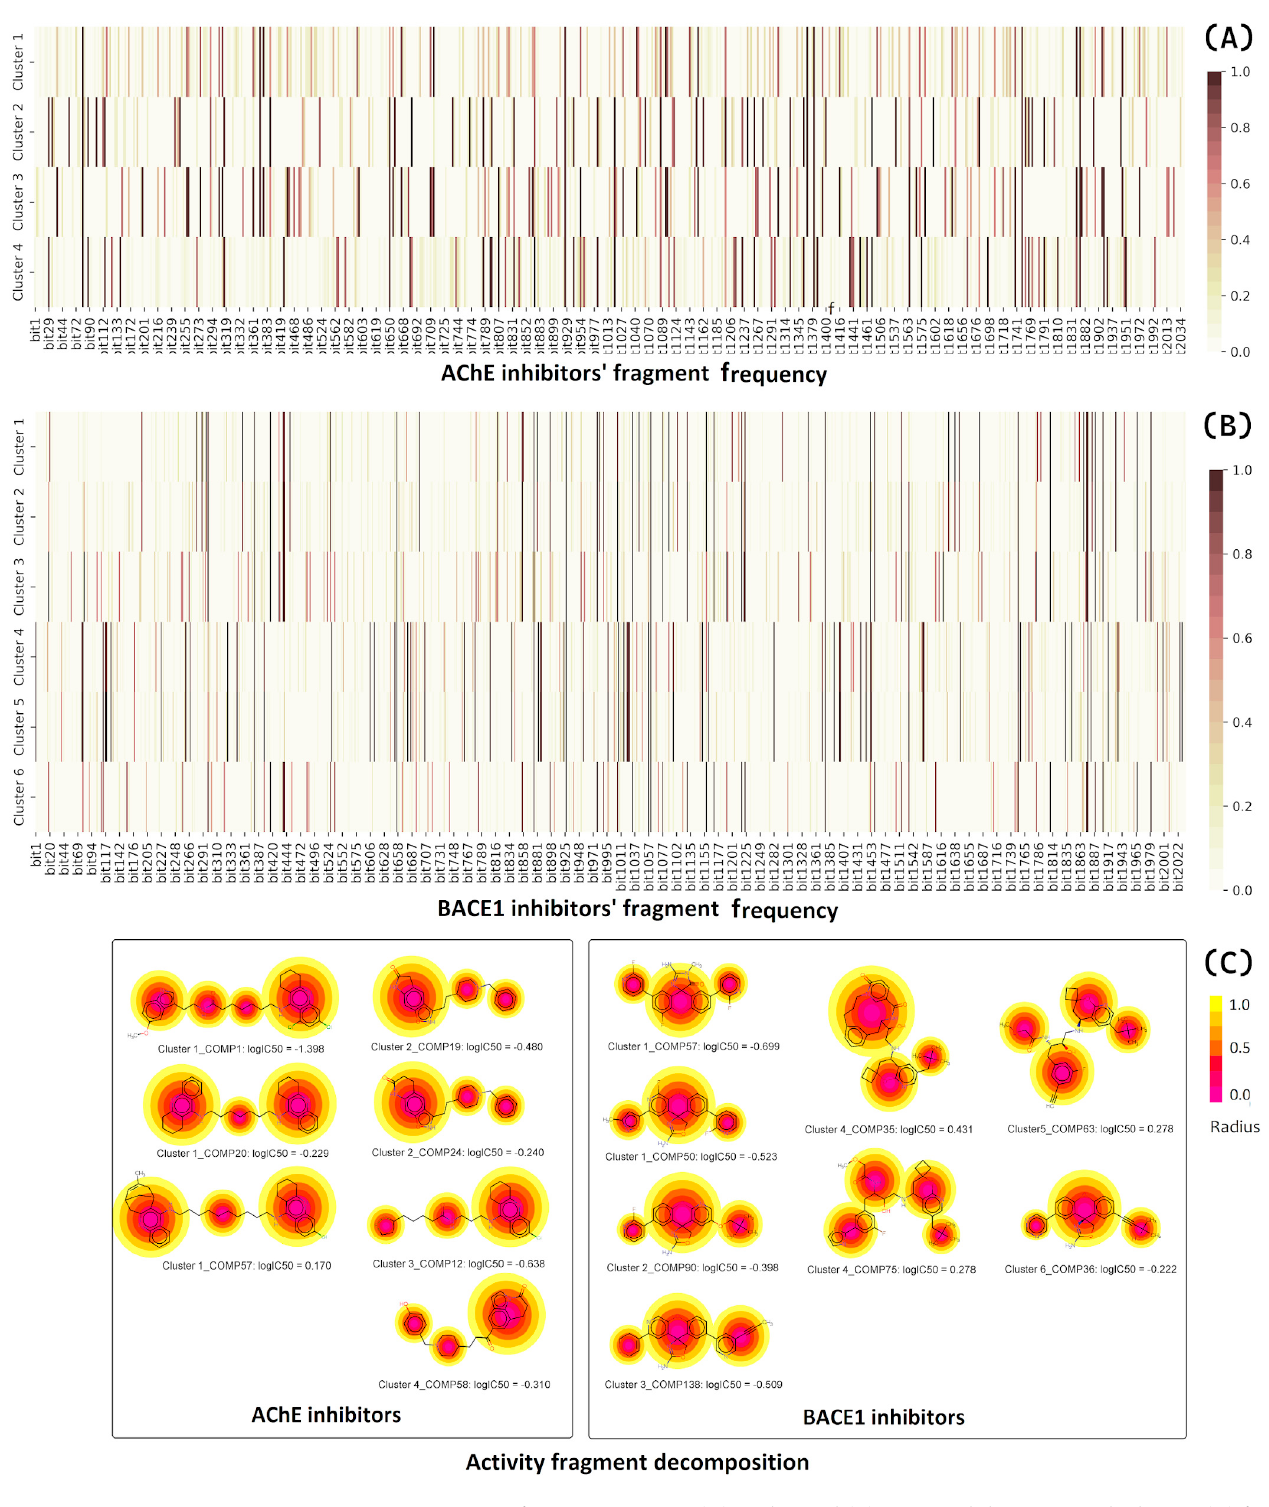
Figure 8. Fingerprint frequency among ( A ) AChE and ( B ) BACE inhibitors in each cluster; ( C ) fragment visualization of the most active inhibitors by Murcko − type decomposition algorithm [50] .